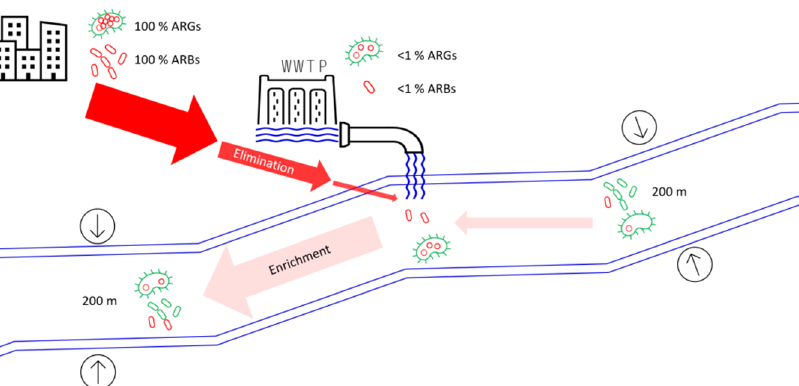
Figure 1. The research focused on estimating the efficiency of wastewater treatment at WWTP Brno has shown high efficiency in the elimination of bacteria and ATB resistance genes in wastewater. Even though the removal efficiency is around 99%, the environment is likely to be enriched. However, according to our results, this enrichment is not already statistically significant 200 m downstream and the values are comparable to upstream.